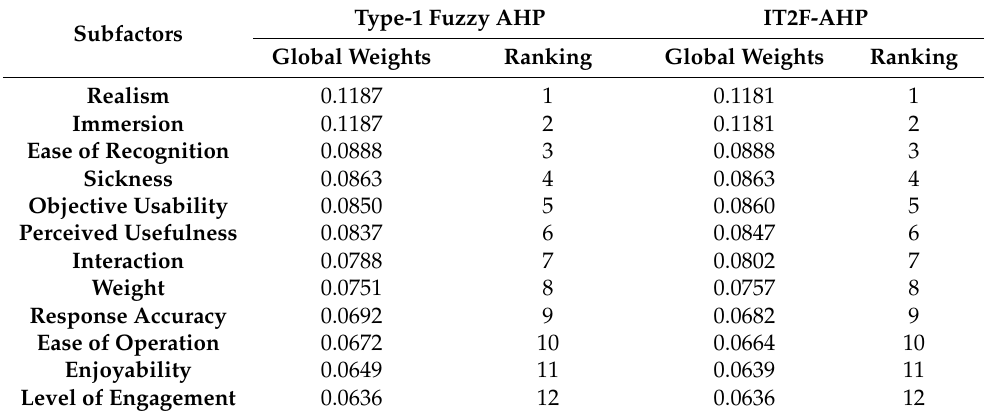
Table 10. Comparison of Type-1 and IT2F-AHP results.